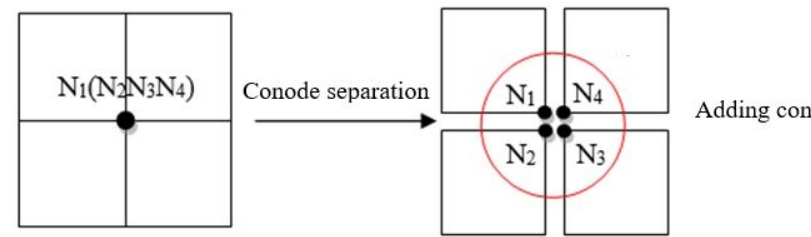
Figure 4. Process of node separation method.